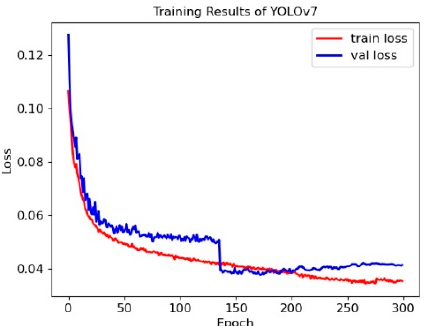
Figure 5. Training results of the YOLOv7